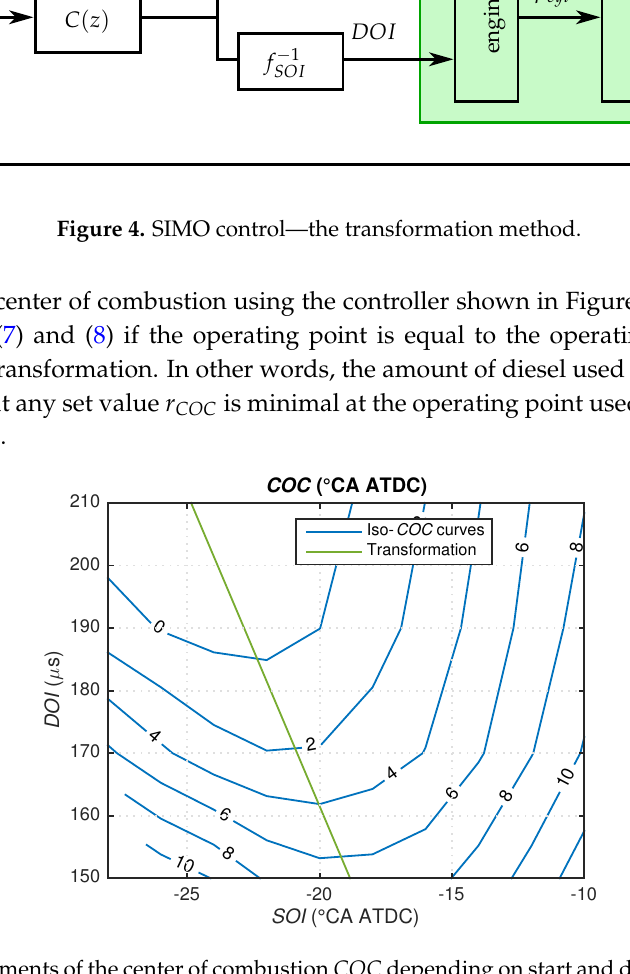
Figure 5. Measurements of the center of combustion COC depending on start and duration of injection SOI and DOI , respectively. The affine approximation of Equation (12) is shown as